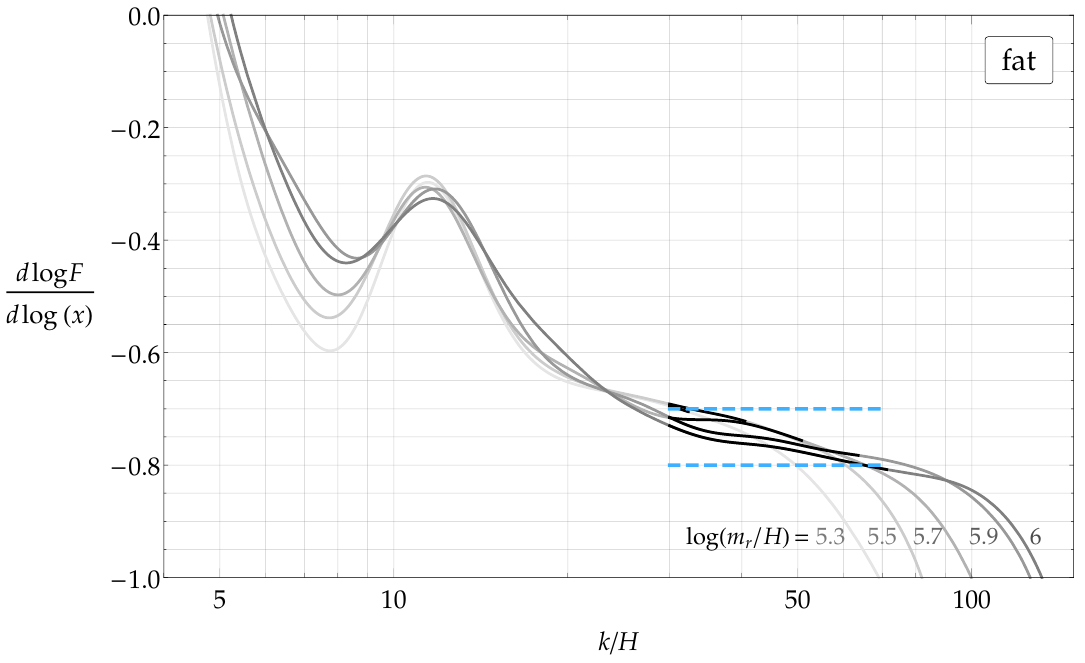
Figure 28 . The value of d log F ( x; y ) =d log x as a function of the rescaled momentum x = k=H , for di(cid:11)erent time shots, i.e. di(cid:11)erent values of y = m r =H , for the fat string system in the scaling regime. The black sections corresponds to momenta 30 H < k < m r = 6, which are su(cid:14)ciently far from the IR and UV peaks to be uncontaminated by e(cid:11)ects at these scales. The roughly constant values in these regions correspond to the value of (cid:0) q in the approximate power law, and the blue dashed lines represent our estimated range for